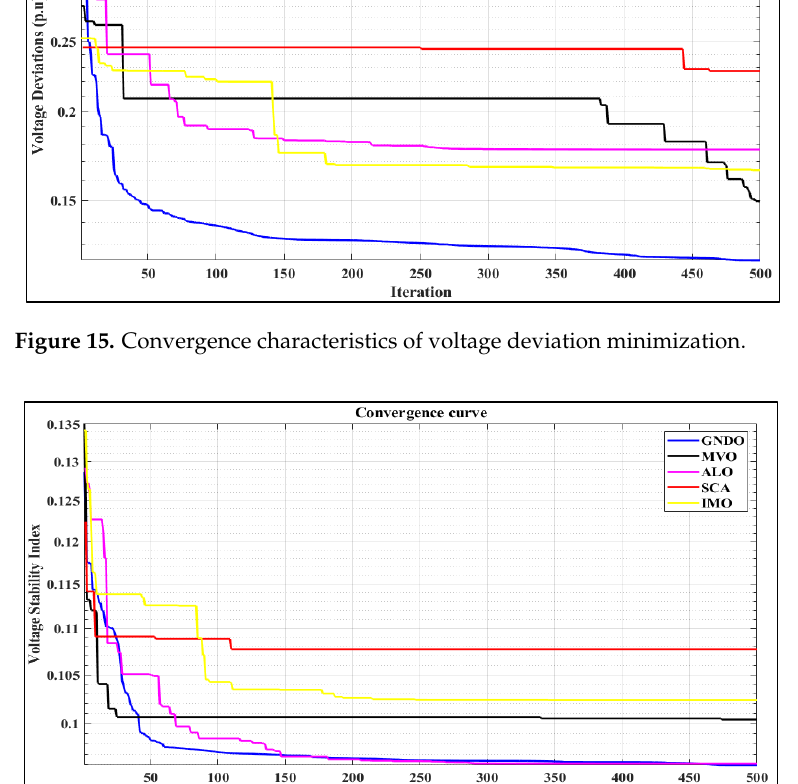
Figure 16. Convergence characteristics of VSI minimization. Table 12. Comparison of the simulation results for single objectives.